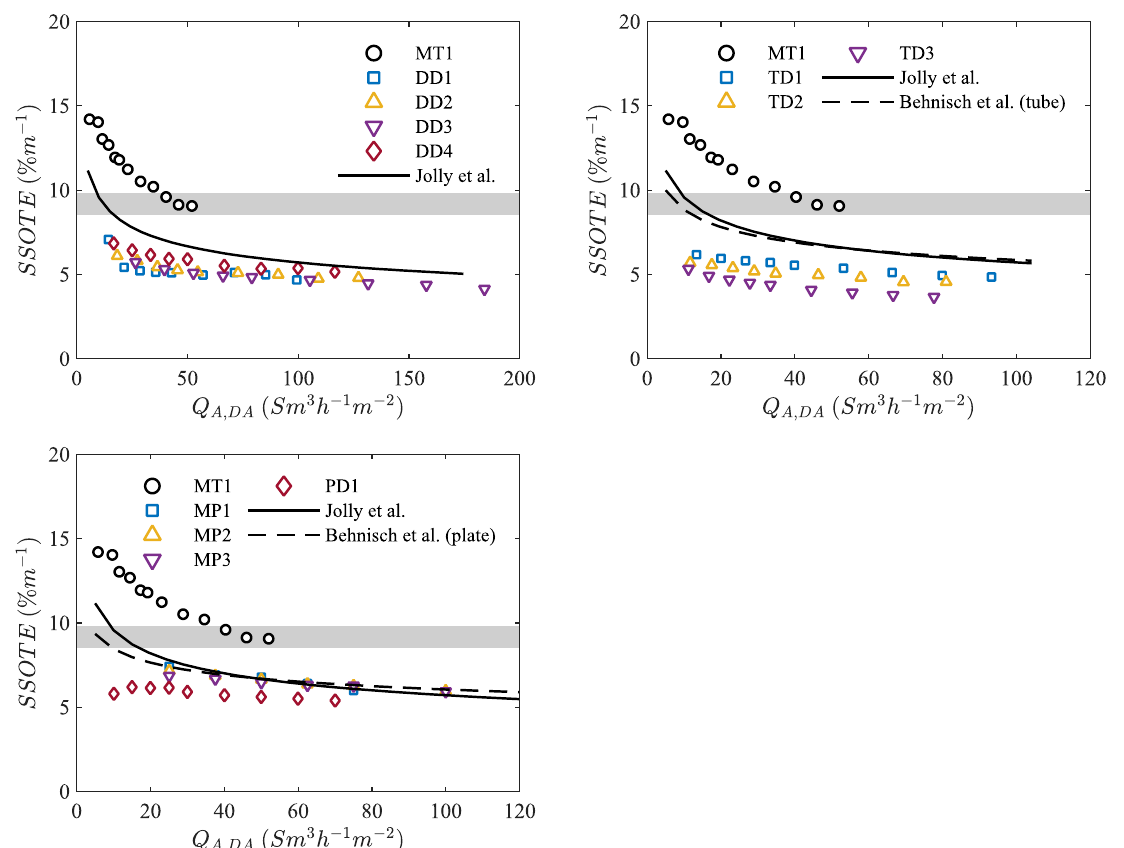
Figure 5. SSOTE versus Q A,DA for all tested diffusers and the micro-perforated diffuser together with the findings from the literature and the favorable SSOTE range of 8.5%·m −1 –9.8%·m −1 [14].